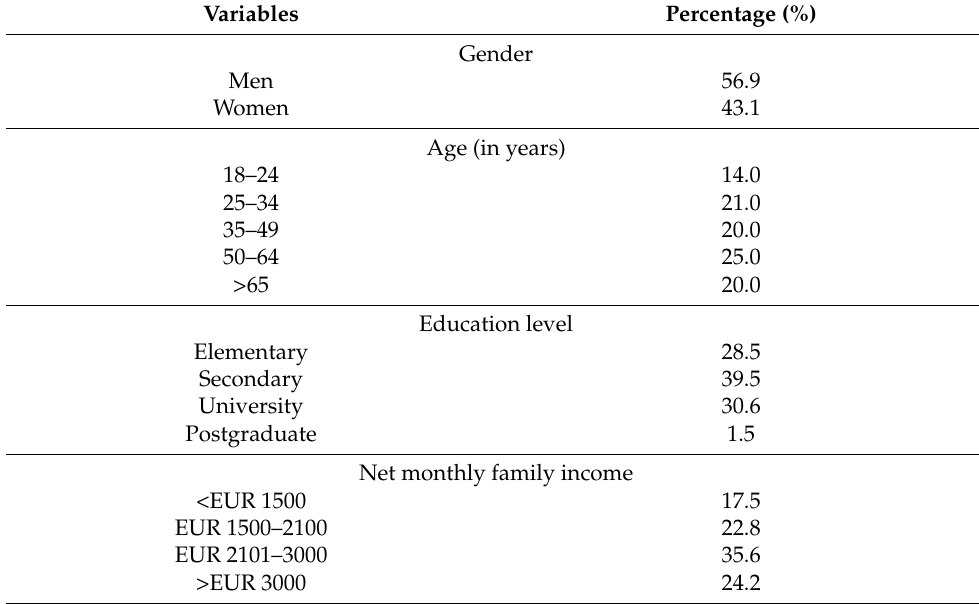
Table 1. Socioeconomic characteristics of the sample